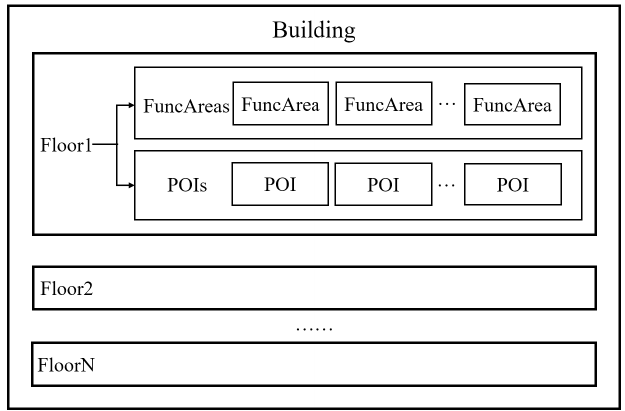
Figure 1. Indoor map data structure. POI, point-of-interest.